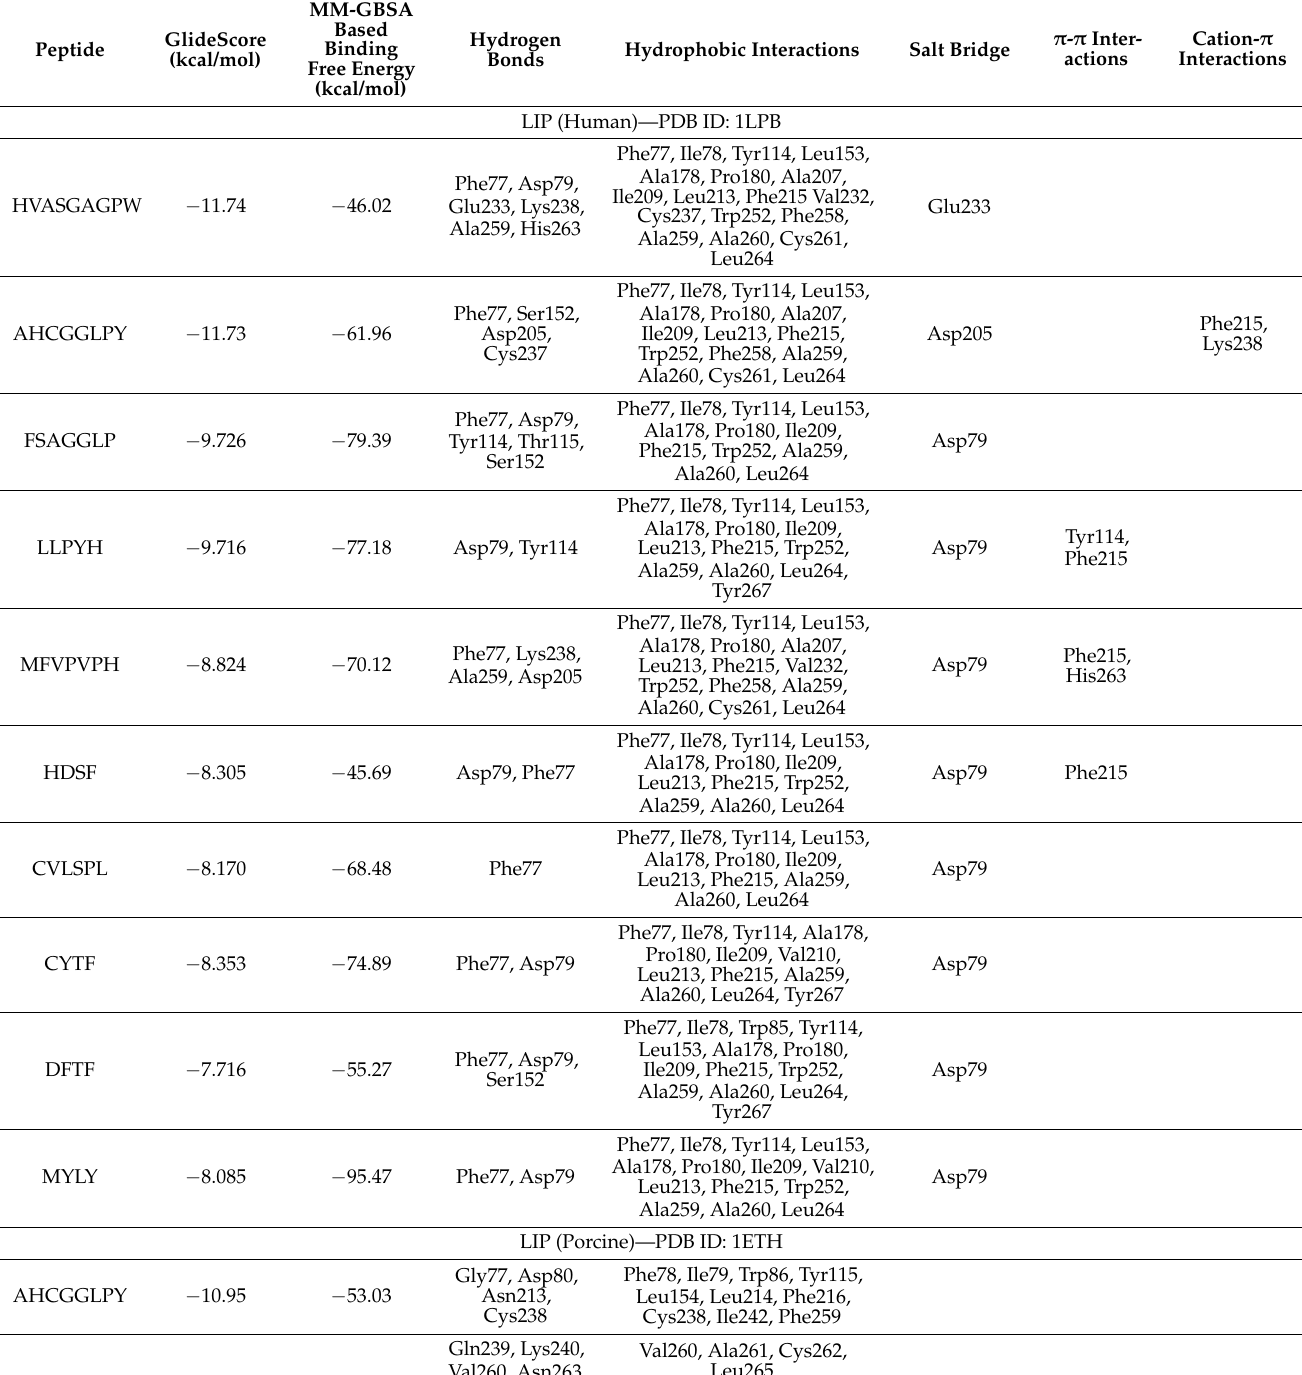
Table 5. Docking score (GlideScore), MM-GBSA binding free energy, and interacting residues of human and porcine PL with the identified